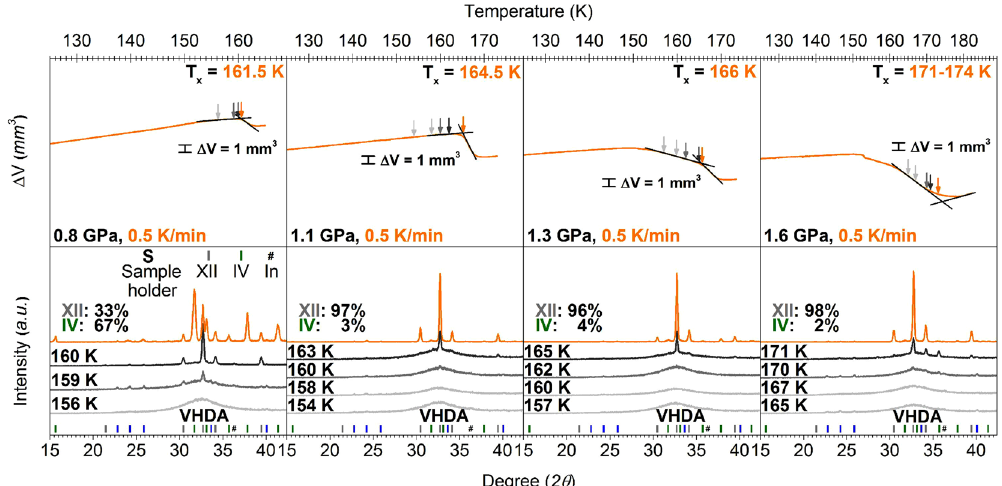
Figure 6. Ex situ x-ray characterization (bottom panels) of samples obtained at various points in volumetric experiments (top panels). For the volumetric experiments samples of VHDA were heated isobarically in a series of experiments at each pressure with 0.5 K min − 1 . Arrows in different grey scales identify temperatures at which samples were quenched and recovered for x-ray characterization. The orange arrow marks T x . Diffractograms are stacked for clarity and their colours match the colours of the arrows. The relative yields of crystalline ices in the phase mixtures are indicated by percentages and marked in different colours (ice IV in green and ice XII in